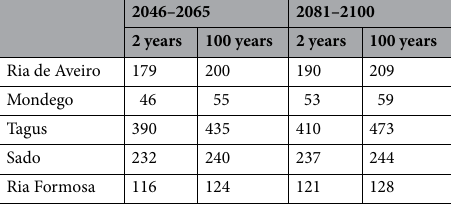
Table 3. Flooded area (km 2 ) predicted for each scenario for each estuarine